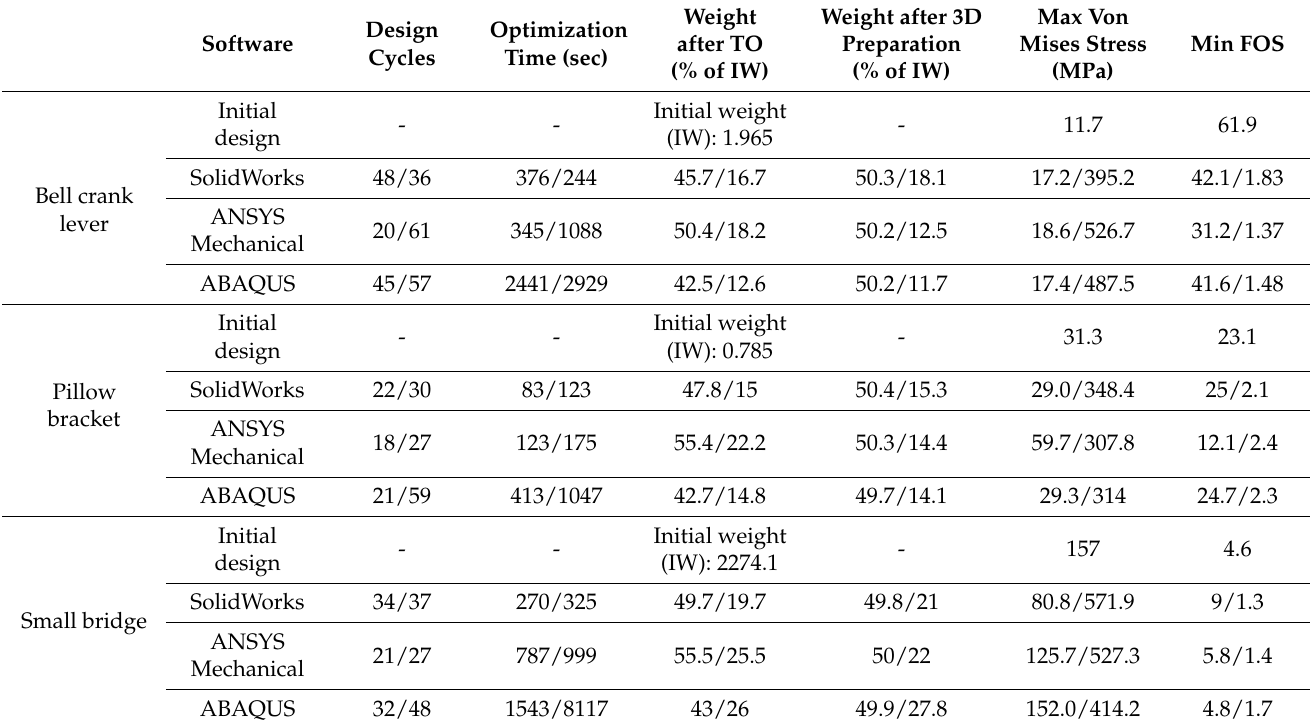
Table 2. The results of the optimizations and validation studies for 50%/maximum weight